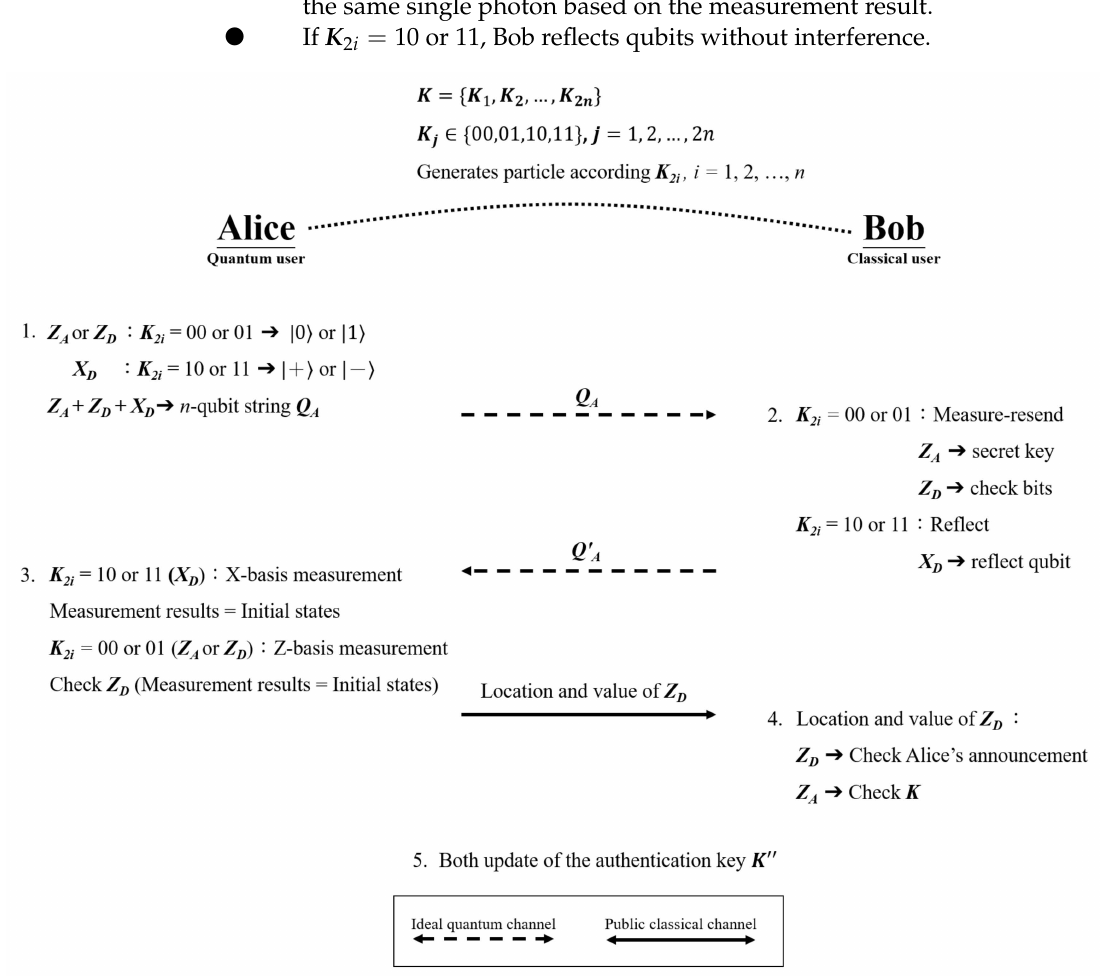
Figure 5. The proposed measure-resend SQA